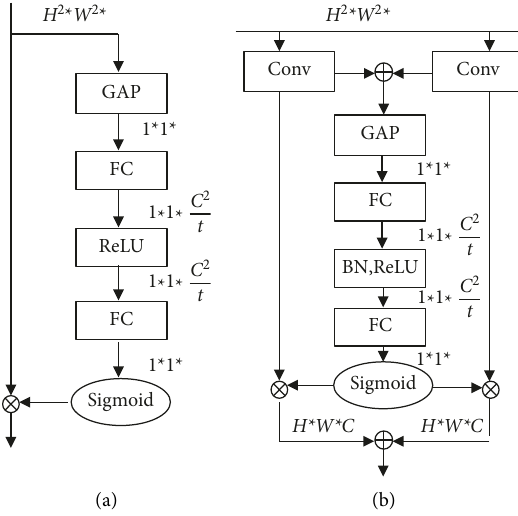
Figure 7: (a) SE module and (b) SK